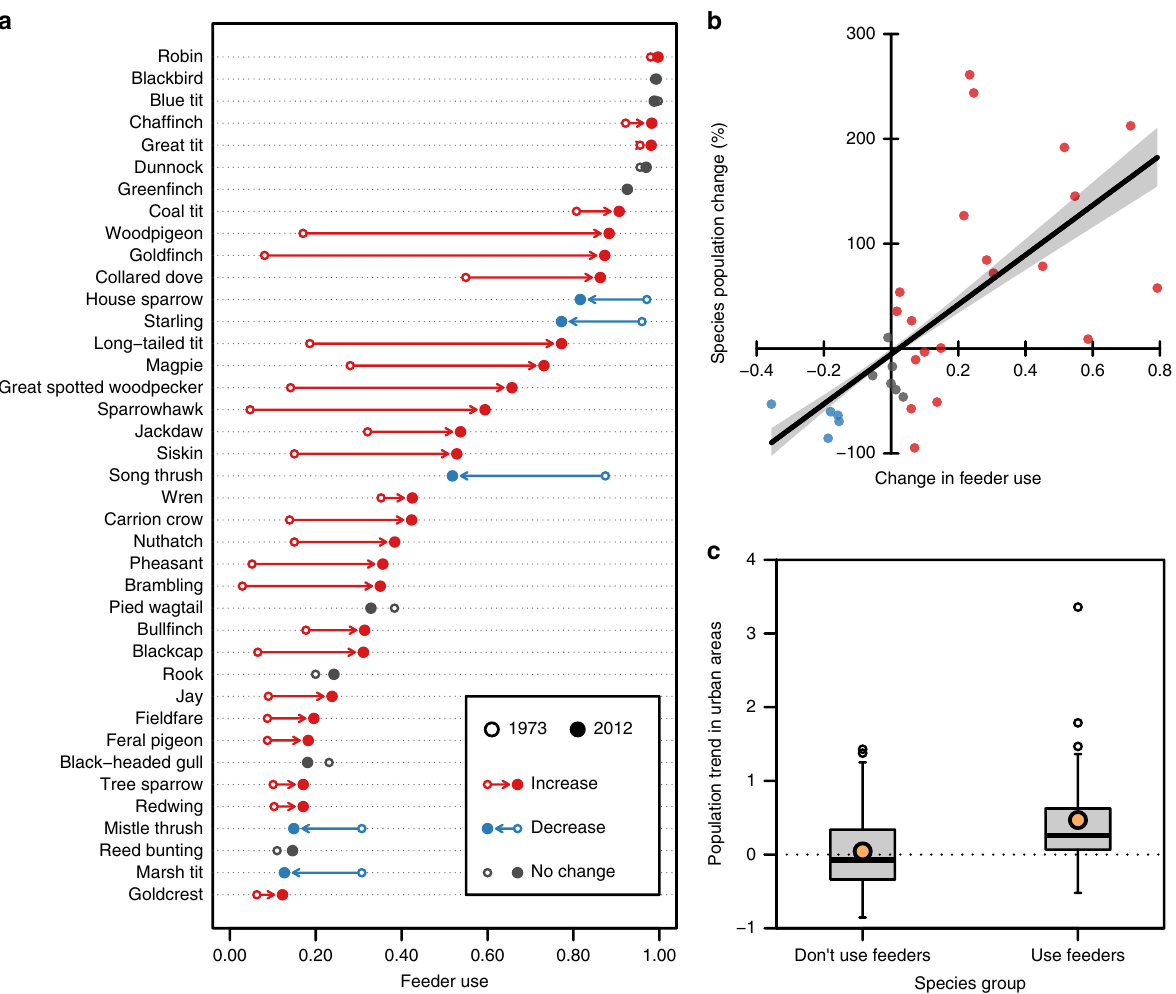
Fig. 3 Effects of garden feeder use on population change. a Change in feeder use (proportion of gardens where species used feeders) by 39 species between 1973 and 2012. b The relationship between the change in feeder use and species national population change over the same timeframe with 95% con fi dence limits ( n = 31 species). Colours, carried over from panel a , depict signi fi cance of food use changes. c Box plot for the difference in urban population trends for species that do ( n = 33) or do not ( n = 39) use garden bird feeders. Boxes bound the interquartile range (IQR) divided by the median, whiskers extend to 1.5 × IQR beyond the boxes and orange dots indicate group